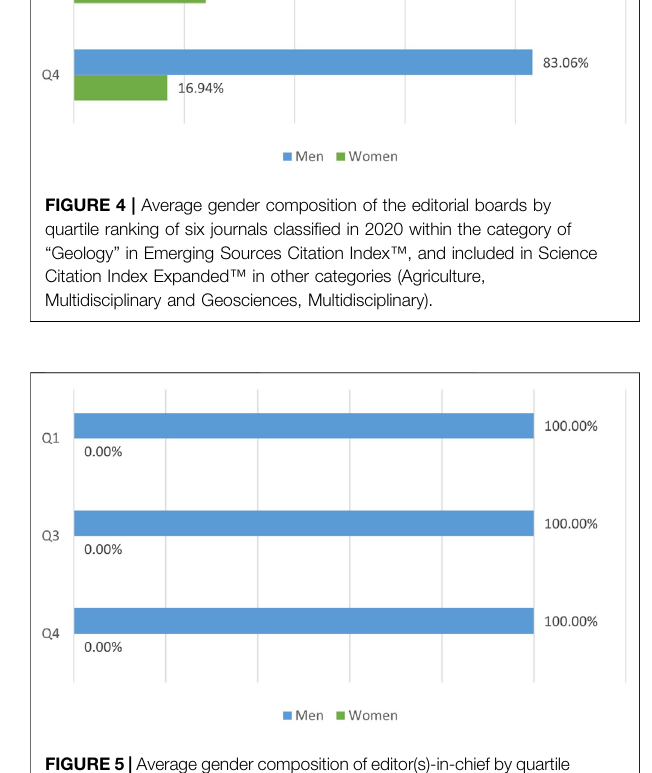
FIGURE 5 | Average gender composition of editor(s)-in-chief by quartile ranking of six journals classi fi ed in 2020 within the category of “ Geology ” in Emerging Sources Citation Index ™ , and included in Science Citation Index Expanded ™ in other categories (Agriculture, Multidisciplinary and Geosciences,